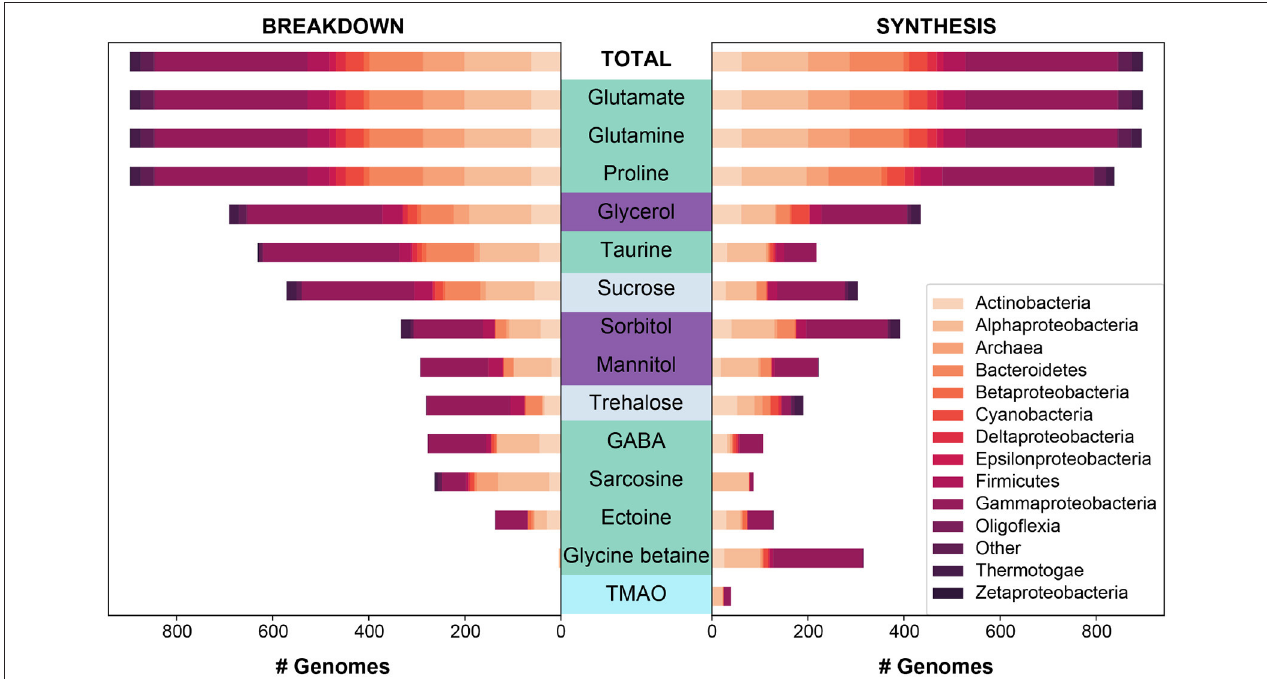
FIGURE 2 | The predicted synthesis and breakdown of targeted osmolytes across all (“Total”) MarRef bacterial and archaeal genomes ( n = 897). The breakdown and synthesis of osmolytes is depicted as a stacked bar graph, and is colored by the designated taxonomic phylum (or class in the case of Proteobacteria). Osmolytes are colored by higher classification: amino acids and derivatives in green, sugar alcohols in purple, sugars in light periwinkle, and an amine oxide in cyan. Osmolytes are sorted along the y-axis based on the total number of genomes capable of breaking down a given